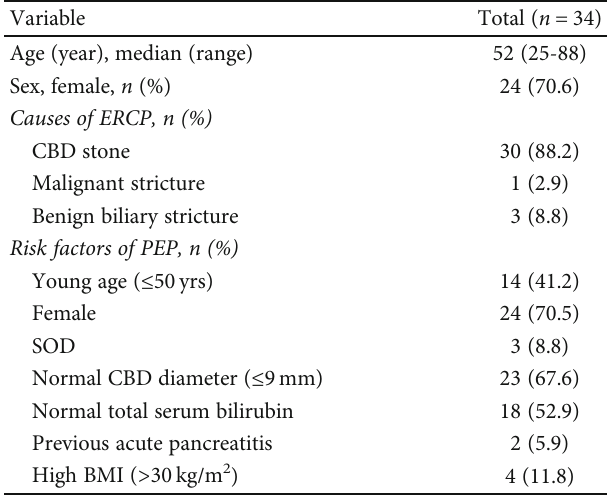
Table 1: Patient baseline characteristics.